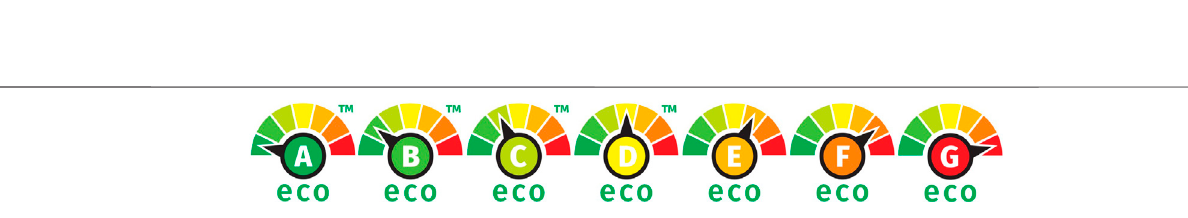
Frontiers in Environmental Science |